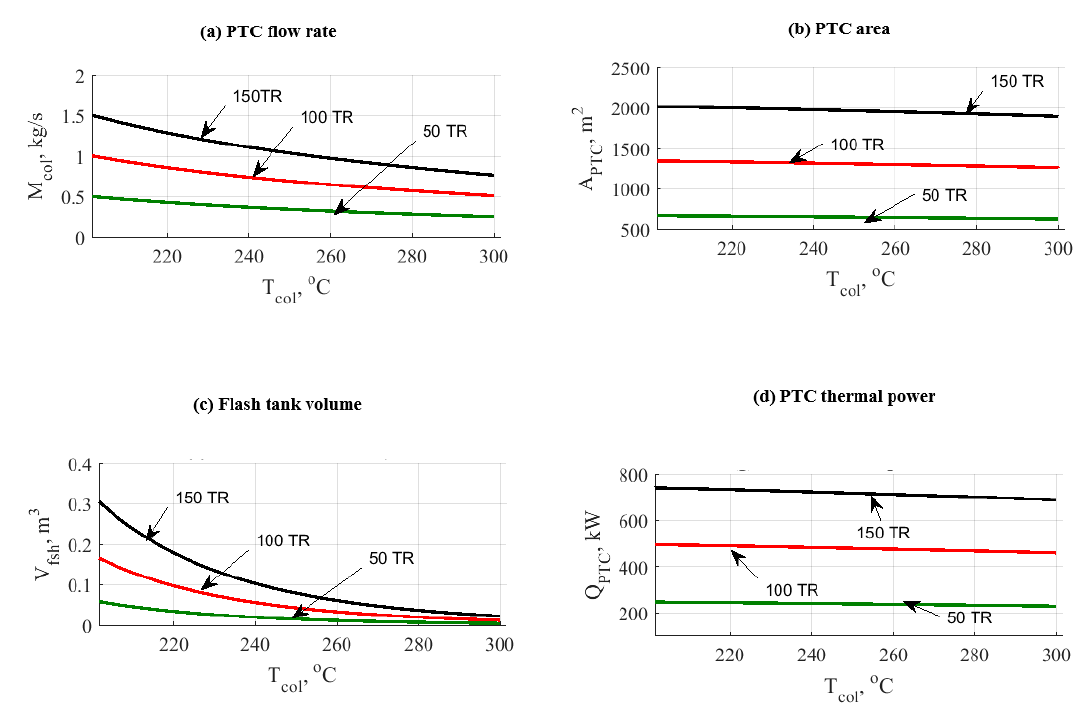
Figure 3. Data results for PTC/H 2 O-LiBr cycle vs. variation in exit upper temperature of the solar field. ( a ) Collector flow rate. ( b ) Solar collector area. ( c ) Flash tank volume. ( d ) Solar thermal power.